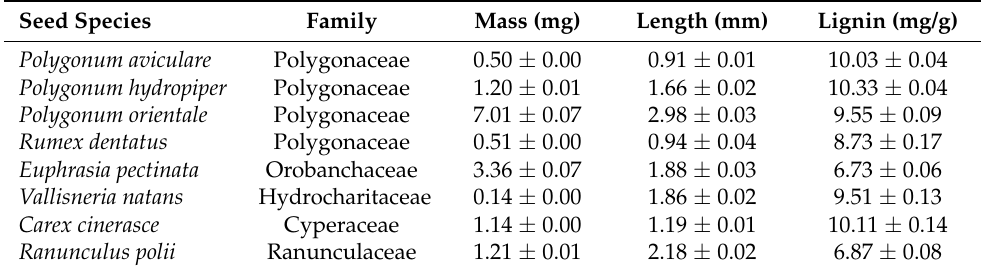
Table 1. Measured mean values of the seed traits ( ± SE) of eight plant species in this study. Seed